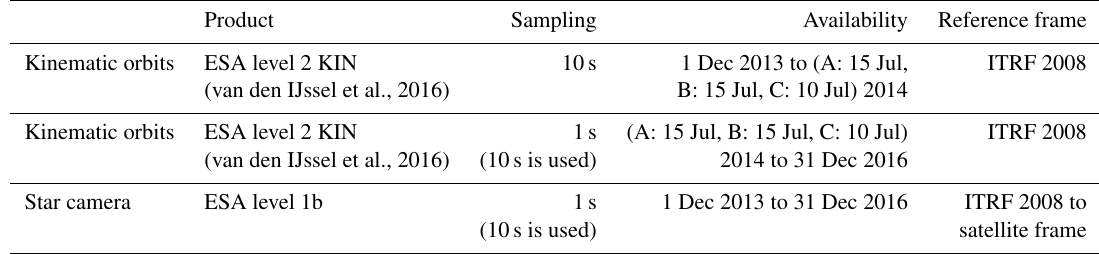
Table 1. Utilized orbit and star camera data.